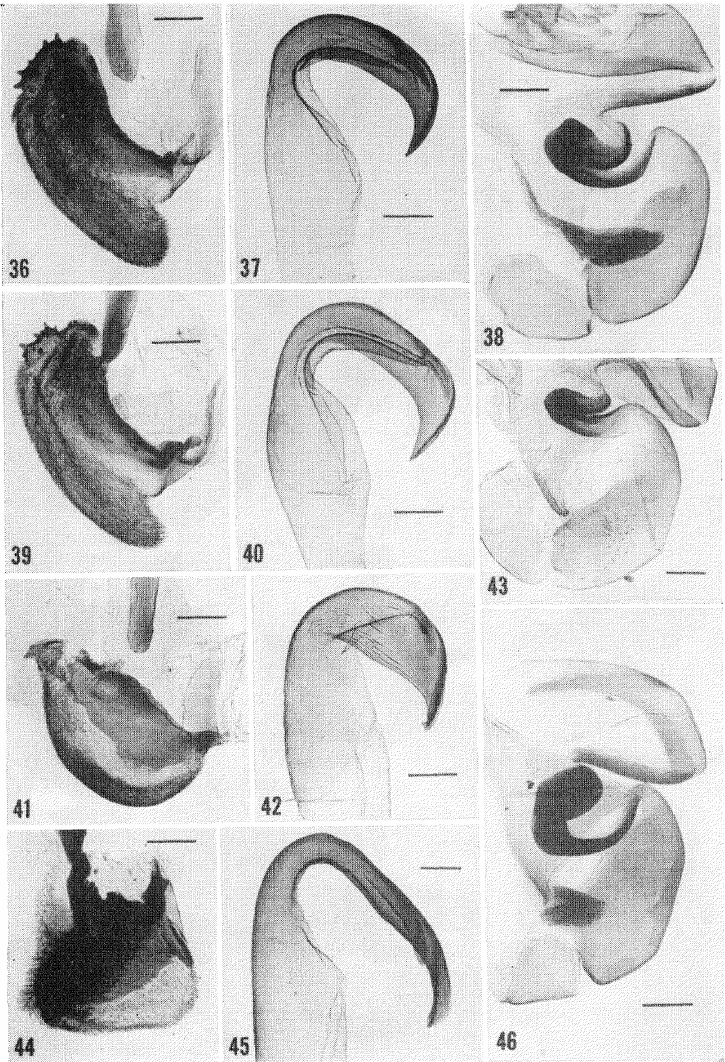
Figs. 36-46. Cockroach male genitalia. 36-38. (4 CUZM). E. con[erta. Callanga, Peru. (det. Princis). 39-40. (121 USNM). E. conferta. Callanga, Dept. of Cusco, Peru. (det. Roth). 41-43. (67 USNM). Epilampra sp. Rio Blanco or Ecuador. (det. as E. mexicana by Albuquerque). The setal brush in Fig. 43 is very lightly pigmented and difficult to see in the photograph. 44-46. (168 USNM). Epilampra sp. Cundinamarca, Colombia. (scale--- 0.2